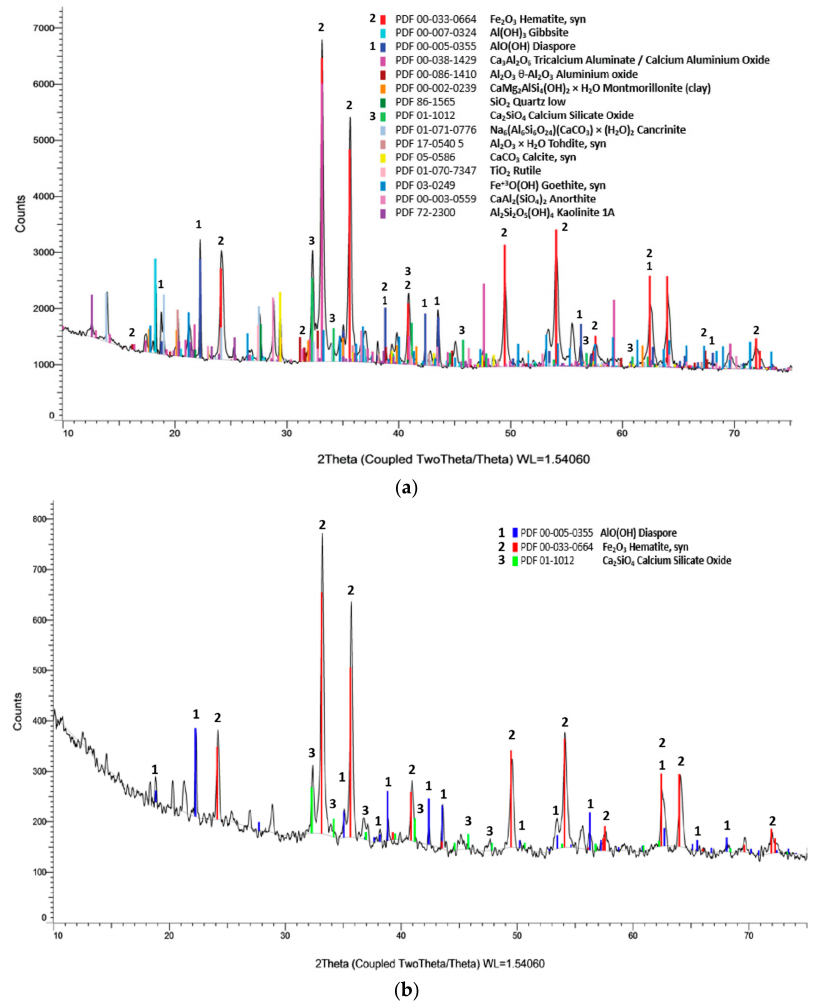
Figure 6. BR mineralogical analysis ( a ) before and ( b ) after leaching process, 1: Diaspore, 2: Hematite, 3: Ca 2 SiO 4 (Leaching conditions: 1 M H 3 PO 4 , S/L 10%, 25 ◦ C, 1